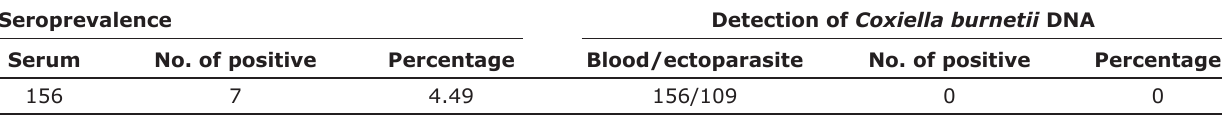
The herd seroprevalence was 13.79% (4/29).